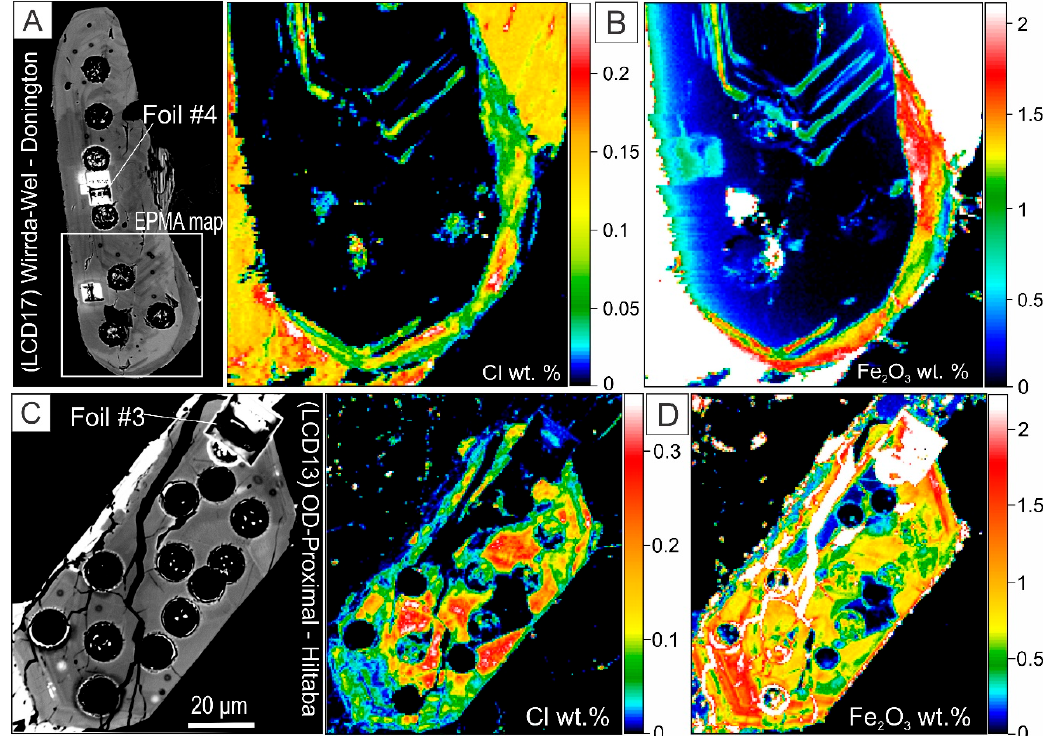
Figure 5. ( A ) BSE image of oscillatory-zoned Wirrda Well–Donington Suite zircon (sample LCD17) that was dated (LA-ICP-MS craters) and used for nanoscale study (foil location as marked). ( B ). EPMA maps for Cl and Fe 2 O 3 (in wt.%), showing that both elements appear homogeneously enriched and positively correlated with one another within oscillatory bands. ( C , D ) BSE image and EPMA maps for Cl and Fe 2 O 3 (wt.%) of OD proximal zircon (sample LCD 13; foil marked at the top). Note the high concentrations of both elements within the middle part which was affected by fractures and re-crystallization. In contrast, crystal zoning on the rim shows inverse correlation between the two elements (e.g., banding intersecting the FIB cut).